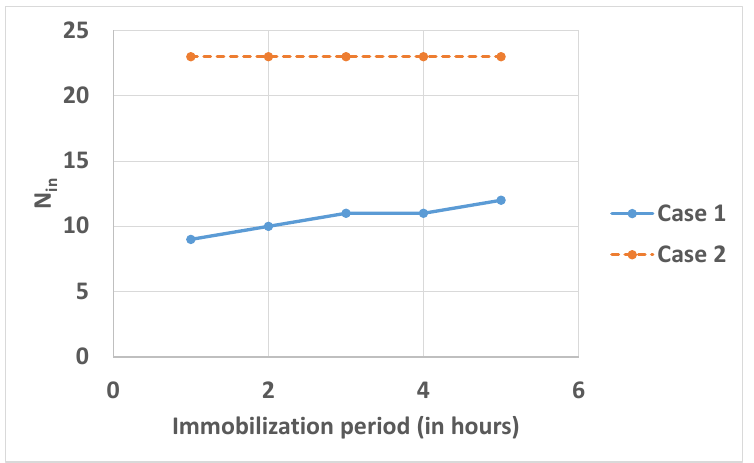
Figure 7. Variation of the optimal N in in terms of period of system immobilization for maintenance: case 1 vs. case